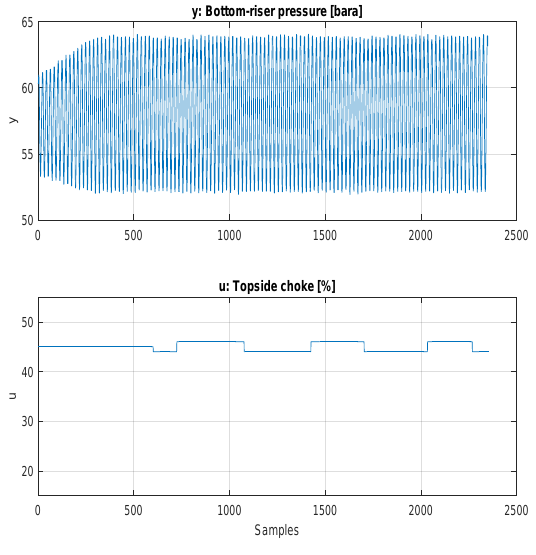
Figure 13: Data collected from the K-Spice/LedaFlow simulator. The data from 600 to 2000 Sam- ples were used for identification, while the data from 600 to 2350 were used for vali- dation. The simulation speed was 50 times real-time. The sampling time is equal to 1 sec.